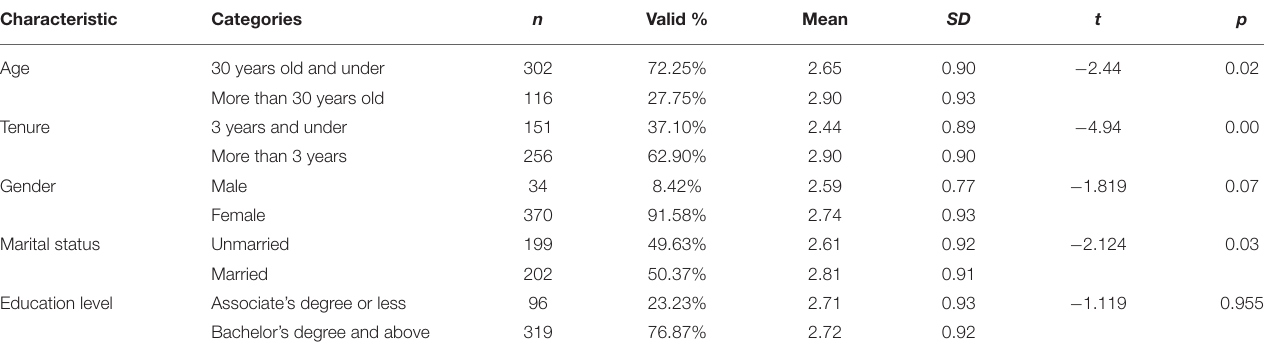
TABLE 2 | Nurse presenteeism differences for individual characteristics.